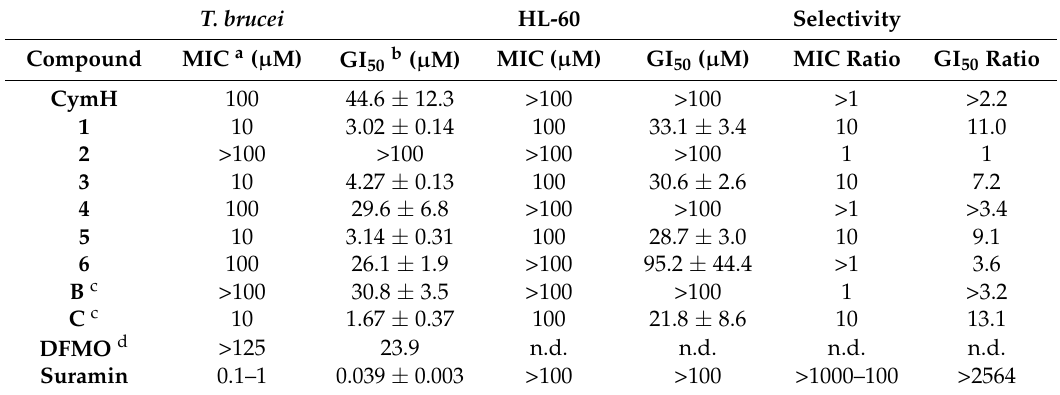
Table 2. The in vitro antitrypanosomal and cytotoxic activity of CymH , compounds 1 – 6 and the reference suramin against T. brucei and human myeloid leukemia HL-60